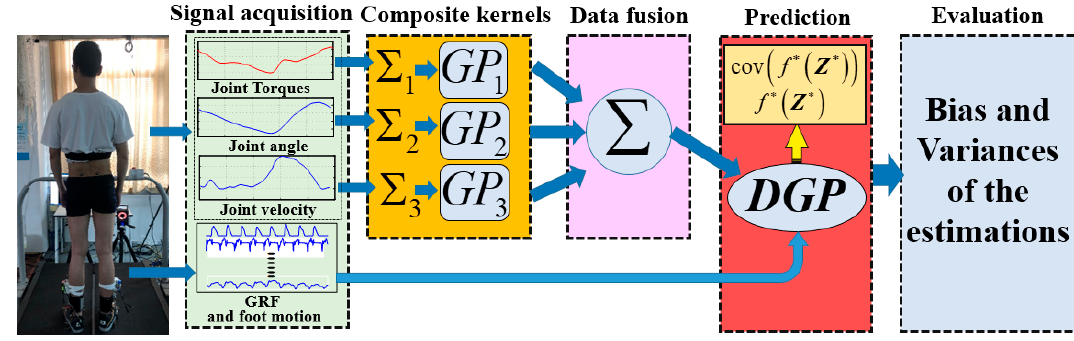
Figure 2. Framework of dependent Gaussian process (DGP)-based data fusion for joint-torque estimations.